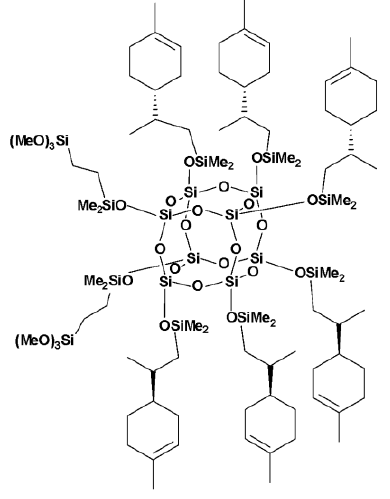
Figure 1. Structure of SS:6LIMO:2VTMOS.